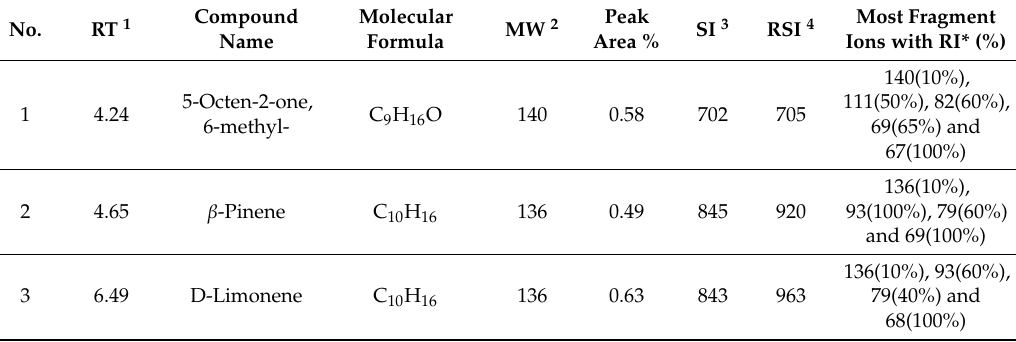
Table 1. Phytochemicals screening of Corymbia citriodora leaf essential oil by gas chromatography–mass spectrometry